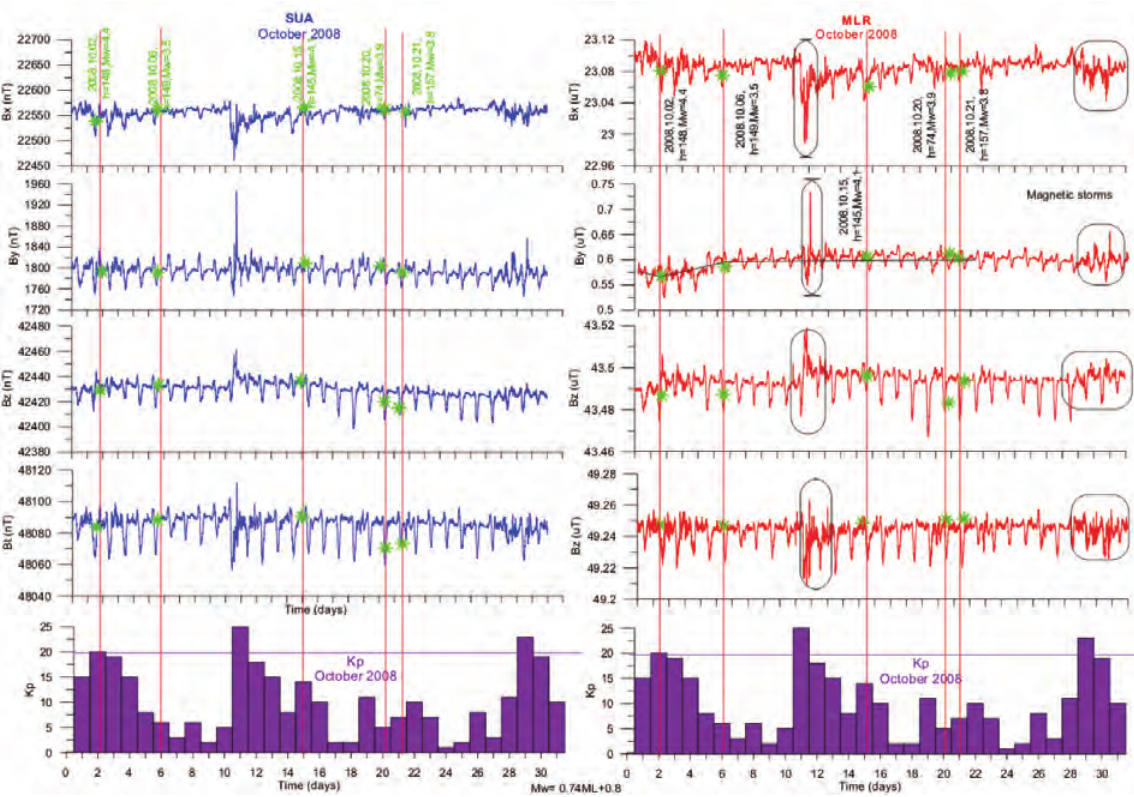
Figure 7. The V-shaped anomaly recorded on the horizontal component By of the MLR Observatory data prior to the Mw = 4.4 (October 2, 2008) crustal Vrancea